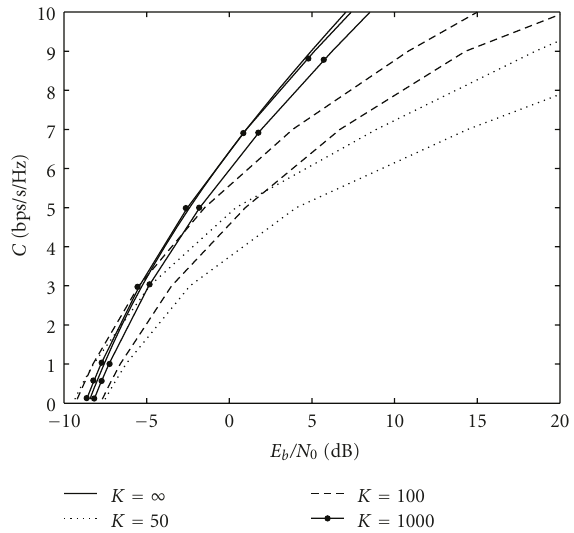
Figure 3: Empirical convergence of extremes with a finite number of